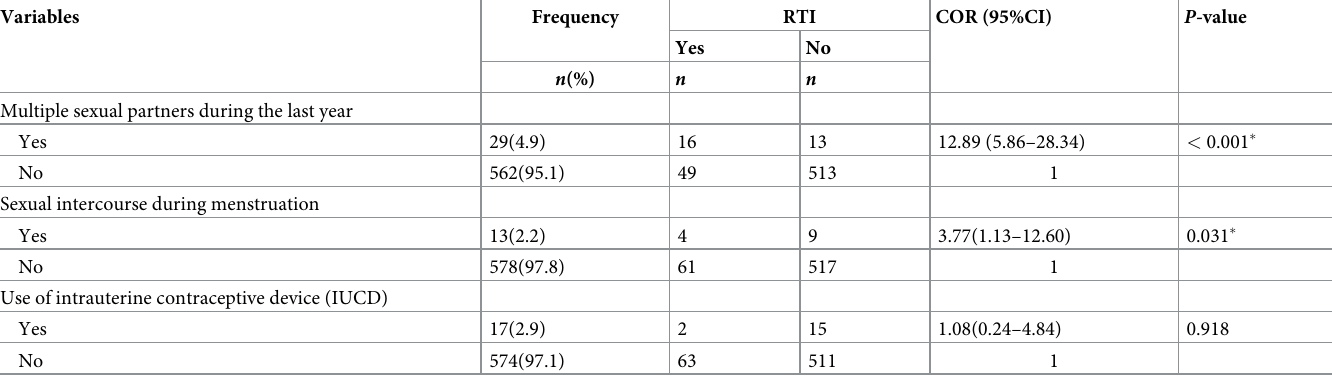
Table 4. Characteristics of behavioral factors among reproductive age women in Dessie City, Ethiopia, January to March 2019.